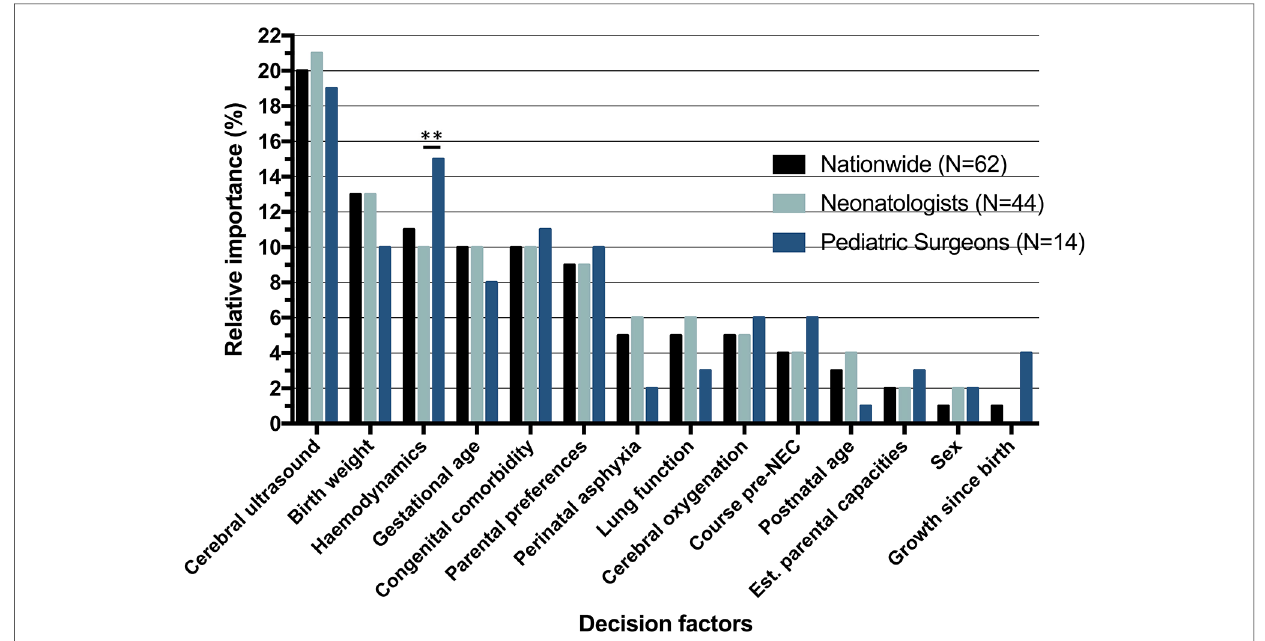
FIGURE 3 Relative importance (RI) of decision factors, nationwide and per specialty. RI determined by : betacoefficient (cid:1) factorrange ( p <0.01) based on standard error of the difference between beta coef fi